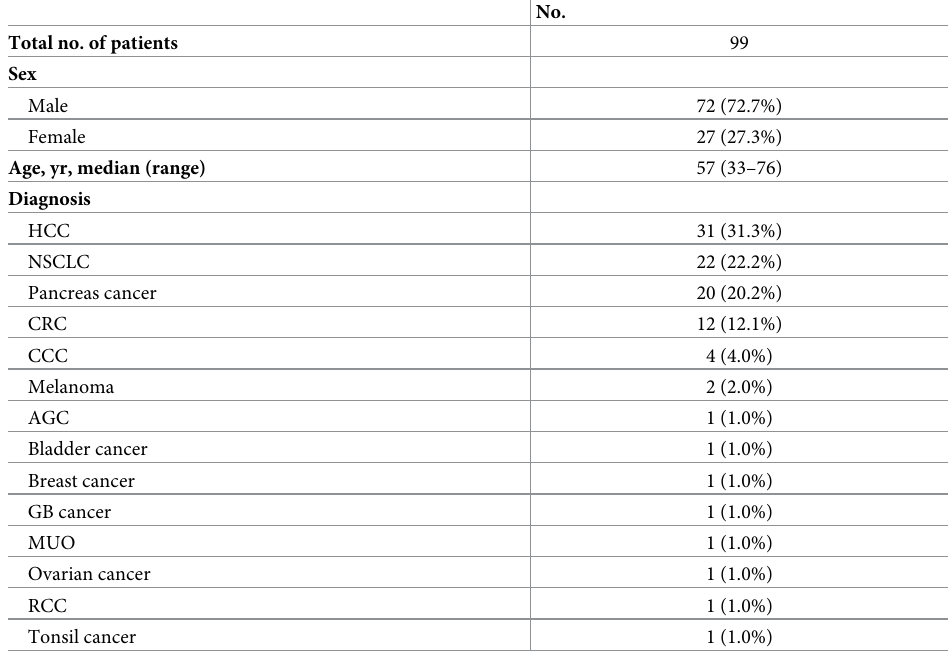
Table 1. Patient demographics.